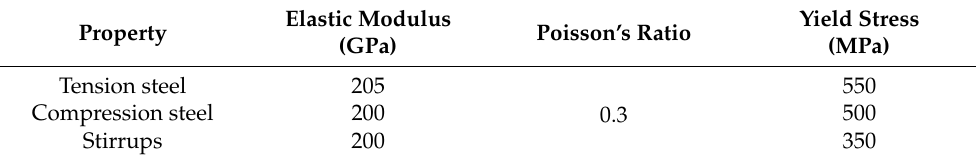
Table 4. Properties of steel reinforcement used in FE simulation, tested by Al-Saawani et al. [6].